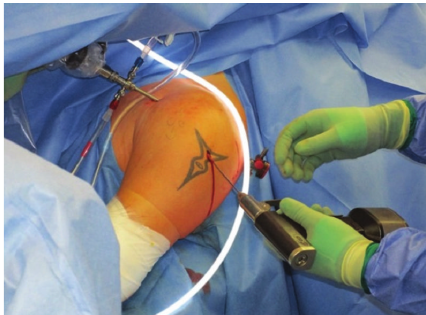
Figure 2: Intraoperative setting with a lateral view (left shoulder). The arthroscope is placed in the anterior portal. A drill pin is placed from a lateral, minimal invasive approach in the area of the reversed Hill-Sachs lesion under fluoroscopic visualization and simultaneous visual control by arthroscopy. Figure 3: Fluoroscopic visualization during the index